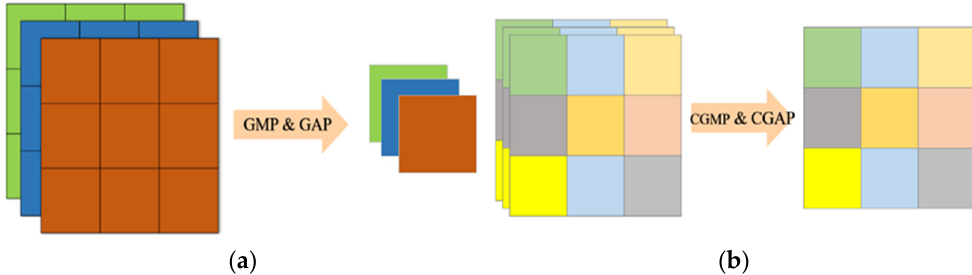
Figure 3. Feature fusion methods: ( a ) GMP fusion and GAP fusion as well as ( b ) CGMP fusion and CGAP fusion.